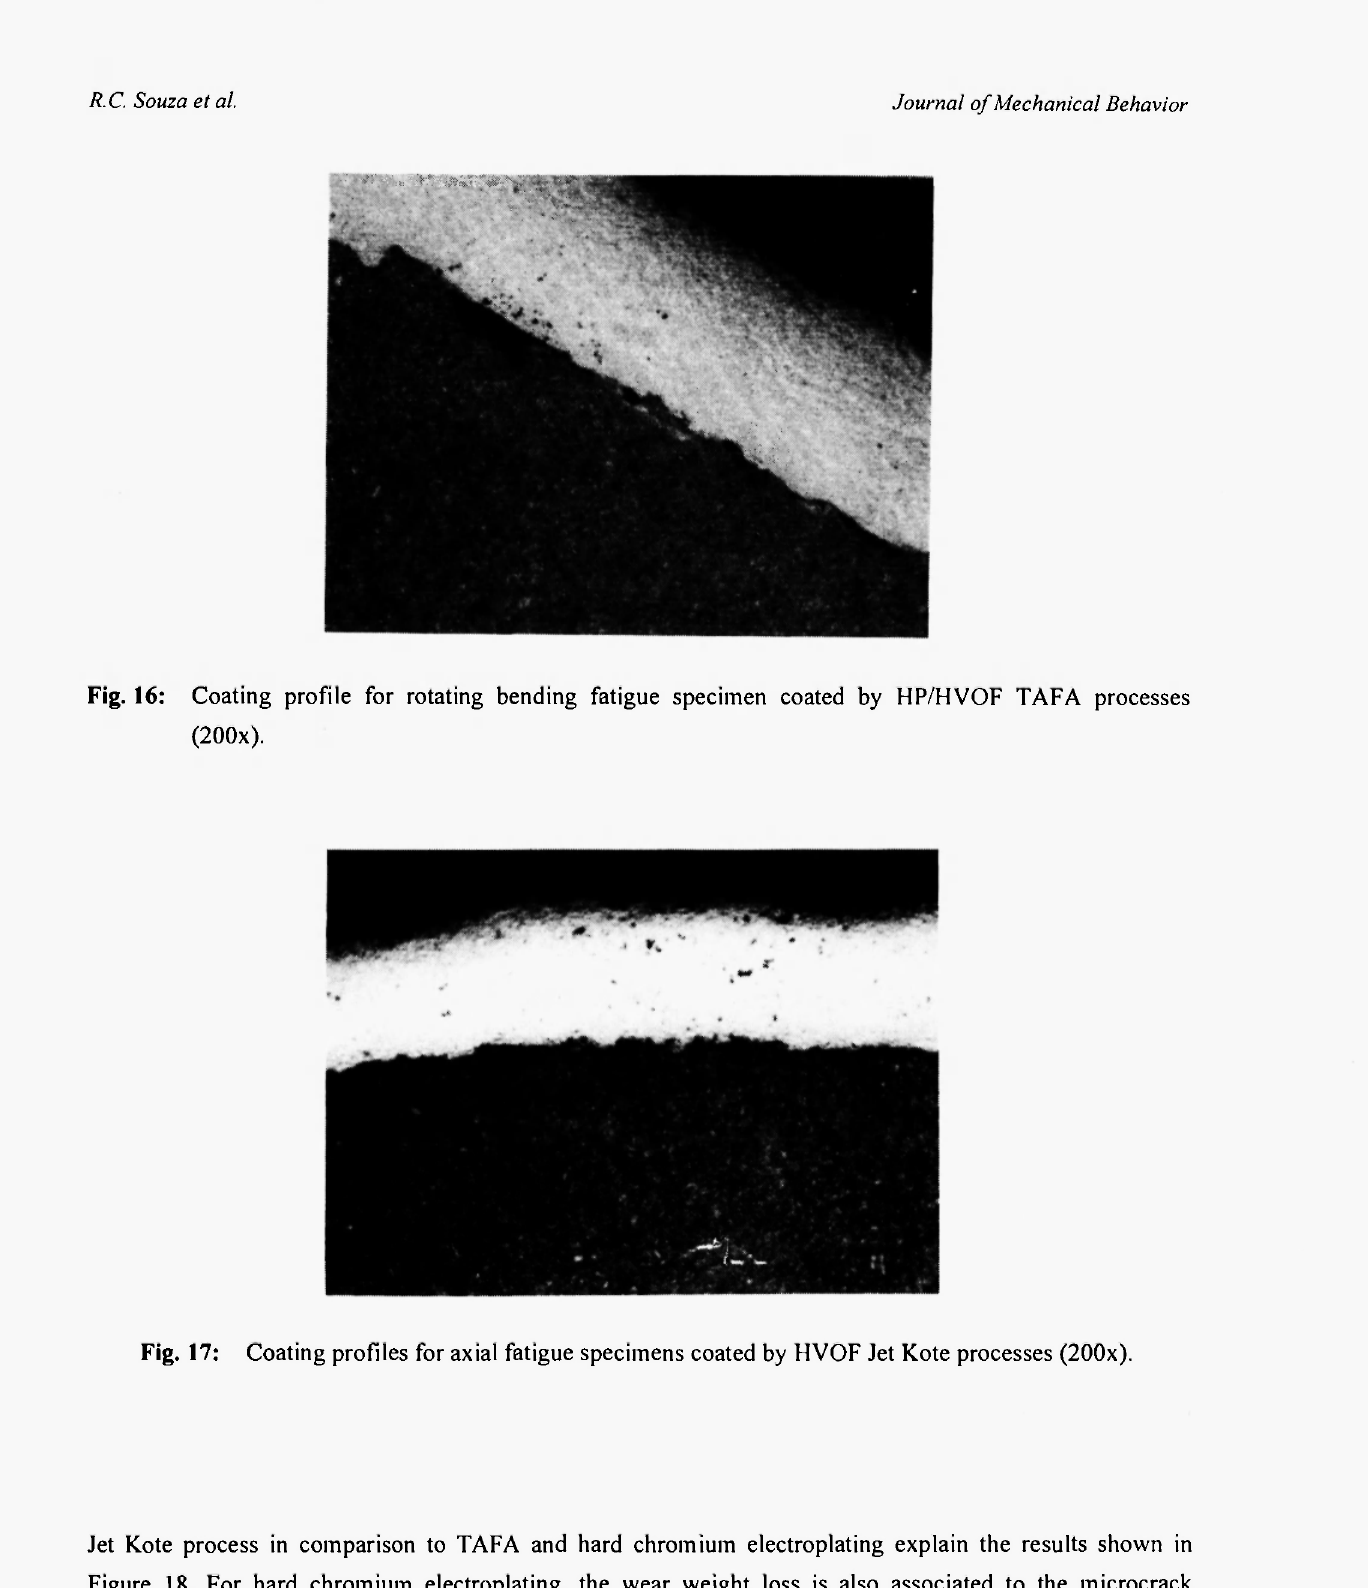
Fig. 17: Coating profiles for axial fatigue specimens coated by HVOF Jet Kote processes (200x).